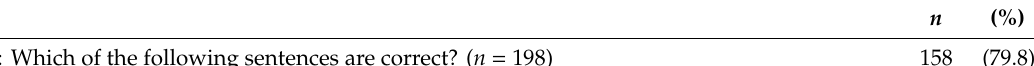
Table 4. Correct responses to knowledge questions